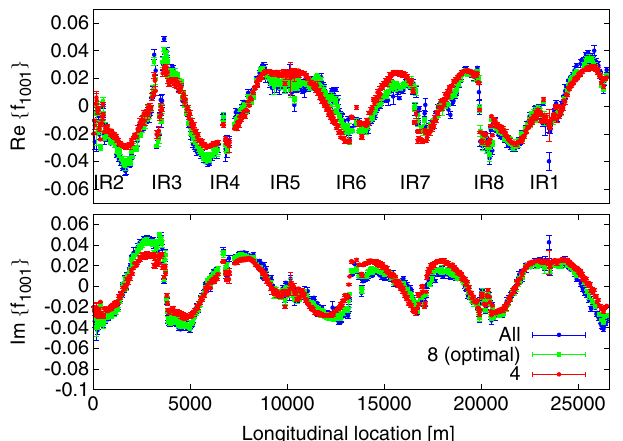
FIG. 4. The f 1001 reconstructed along the machine at injection for different number of singular